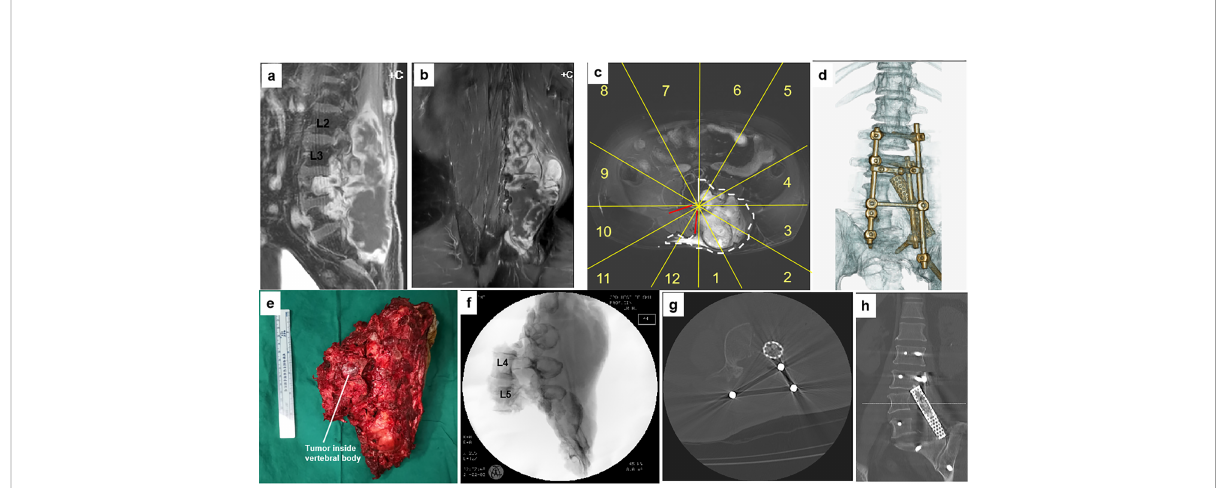
FIGURE 4 A 61-year-old man with a malignant neurilemmoma at L4 – 5. Preoperative MR images (A – C) show the tumor invading the left side of the L4 and L5 vertebrae sectors 1 – 6, (D) , WBB with a huge mass in the posterior elements (from L2 to S3). The patient underwent a two-stage surgery, consisting of anterior release followed by posterior sagittal en bloc resection with instrumentation. A photo of the gross specimen (E) and postoperative CT scan imaging (F – H) showing the margins on sagittal scans of en bloc resection. Postoperative CT scan reconstruction shows structural reconstruction with instrumentation after sagittal resection (D) . WBB, Weinstein – Boriani –